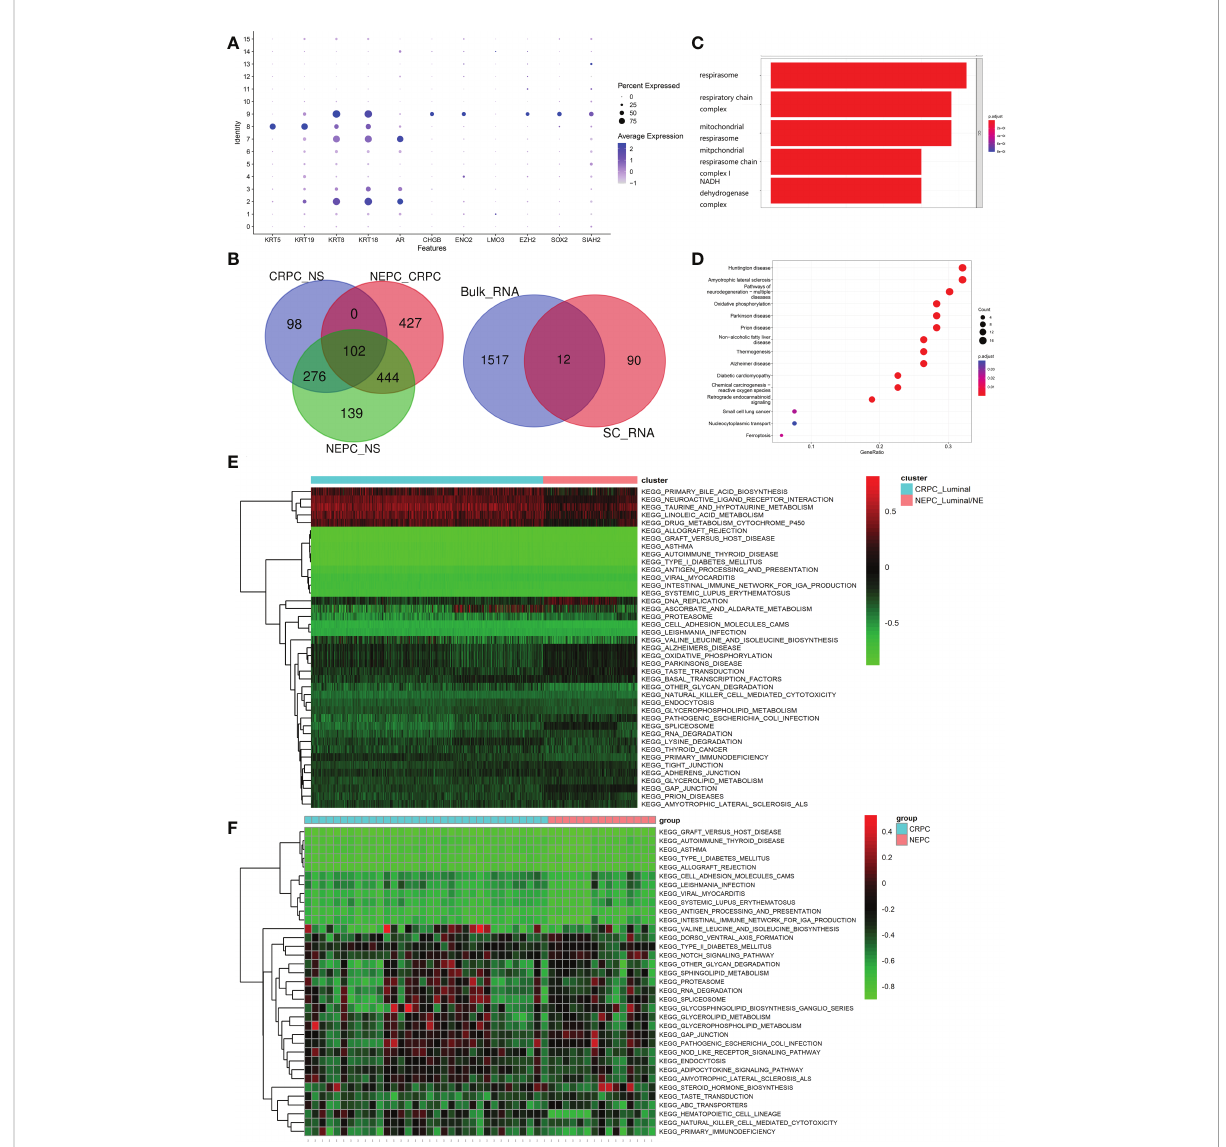
FIGURE 5 Identi fi cation and functional analysis of CRPC-NE featured markers. (A) Marker gene expression for epithelial cells (KRT5, KRT19, KRT8, KRT18, AR) and neuroendocrine characteristic cells (CHGB, ENO2, LMO3, EZH2, SOX2, SIAH2), in which dot size and color represent percentage of marker gene expression and the averaged scaled expression value, respectively. (B) 102 genes with higher expression in NEPC than that in CRPC, and the latter is higher than that in NS were screened out. Then we selected genes shared between the SC-RNA data (102 genes) and Bulk-RNA data (1529 genes). (C, D) GO enrichment and KEGG pathway enrichment analysis of differentially expressed 102 genes. (E, F) Heatmap illustrating the differential KEGG pathways (upper panel) between CRPC_Luminal cluster and NEPC_Luminal/NE cluster at the single cell RNA-seq level, and discrepant KEGG pathway (lower panel) from the aspect of Bulk-RNA seq. The color indicates the level of pathway